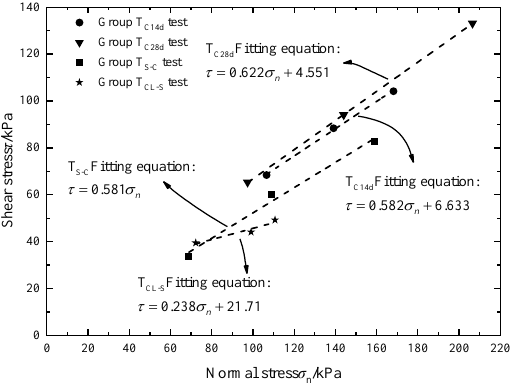
Figure 17. Fitting curve of continuous loading of variable normal stress.